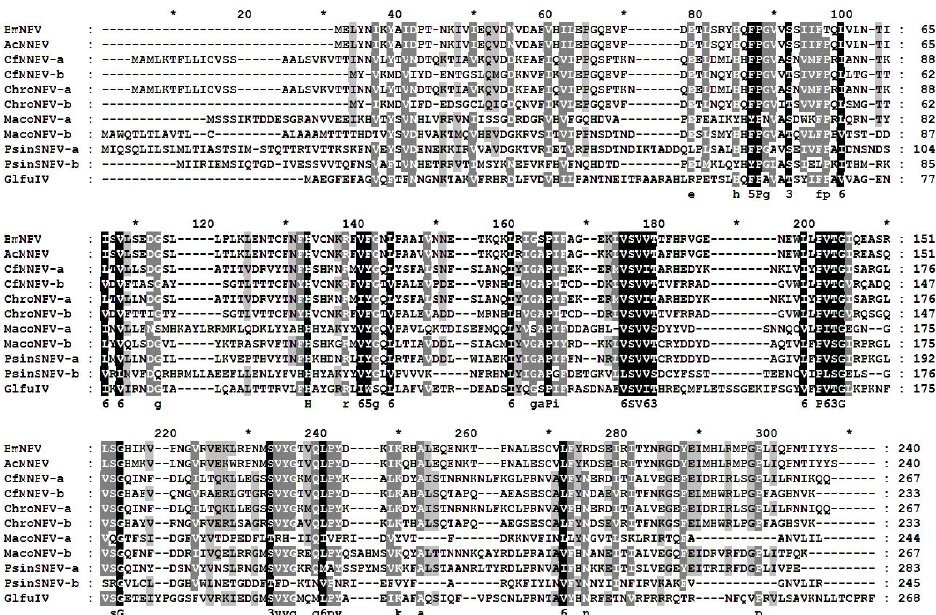
Figure A1. Amino acid sequence alignment of p26 homologs in Bombyx mori nucleopolyhedrovirus (BmNPV, GenBank NP_047534), Autographa californica nucleopolyhedrovirus (AcMNPV, GenBank